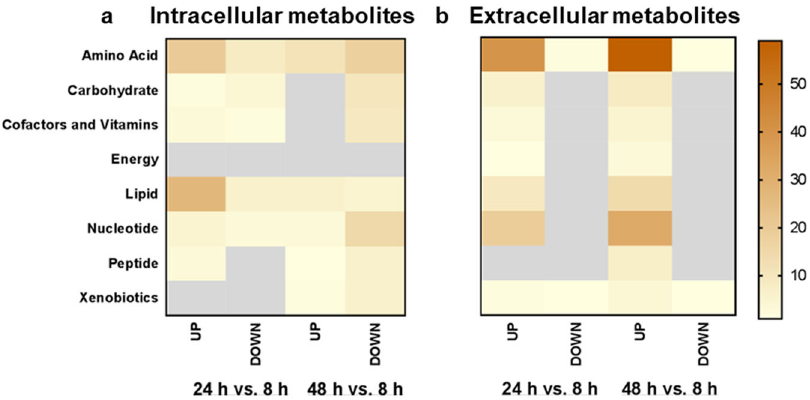
Fig. 2 Intracellular and extracellular metabolomics in aging bio fi lms. Differentially abundant metabolites from each metabolite family were counted and plotted as a heat map. The extent of the metabolic changes is color-coded with darker fi llings for bigger changes. The scale bar indicates the metabolite counts within one metabolite family. No signi fi cant changes are marked in gray. Cutoff p < 0.05 and log 2 FC ± 1. Source data are provided as a Source Data fi le. a The intracellular metabolite content increased after 24 h, but after 48 h of bio fi lm formation, many metabolites decreased signi fi cantly. The largest decline was observed for the nitrogenous substrates (amino acids and nucleotides). b Many metabolites accumulated in the extracellular metabolome in mature bio fi lms as amino acids and nucleotides were most abundant at the late time